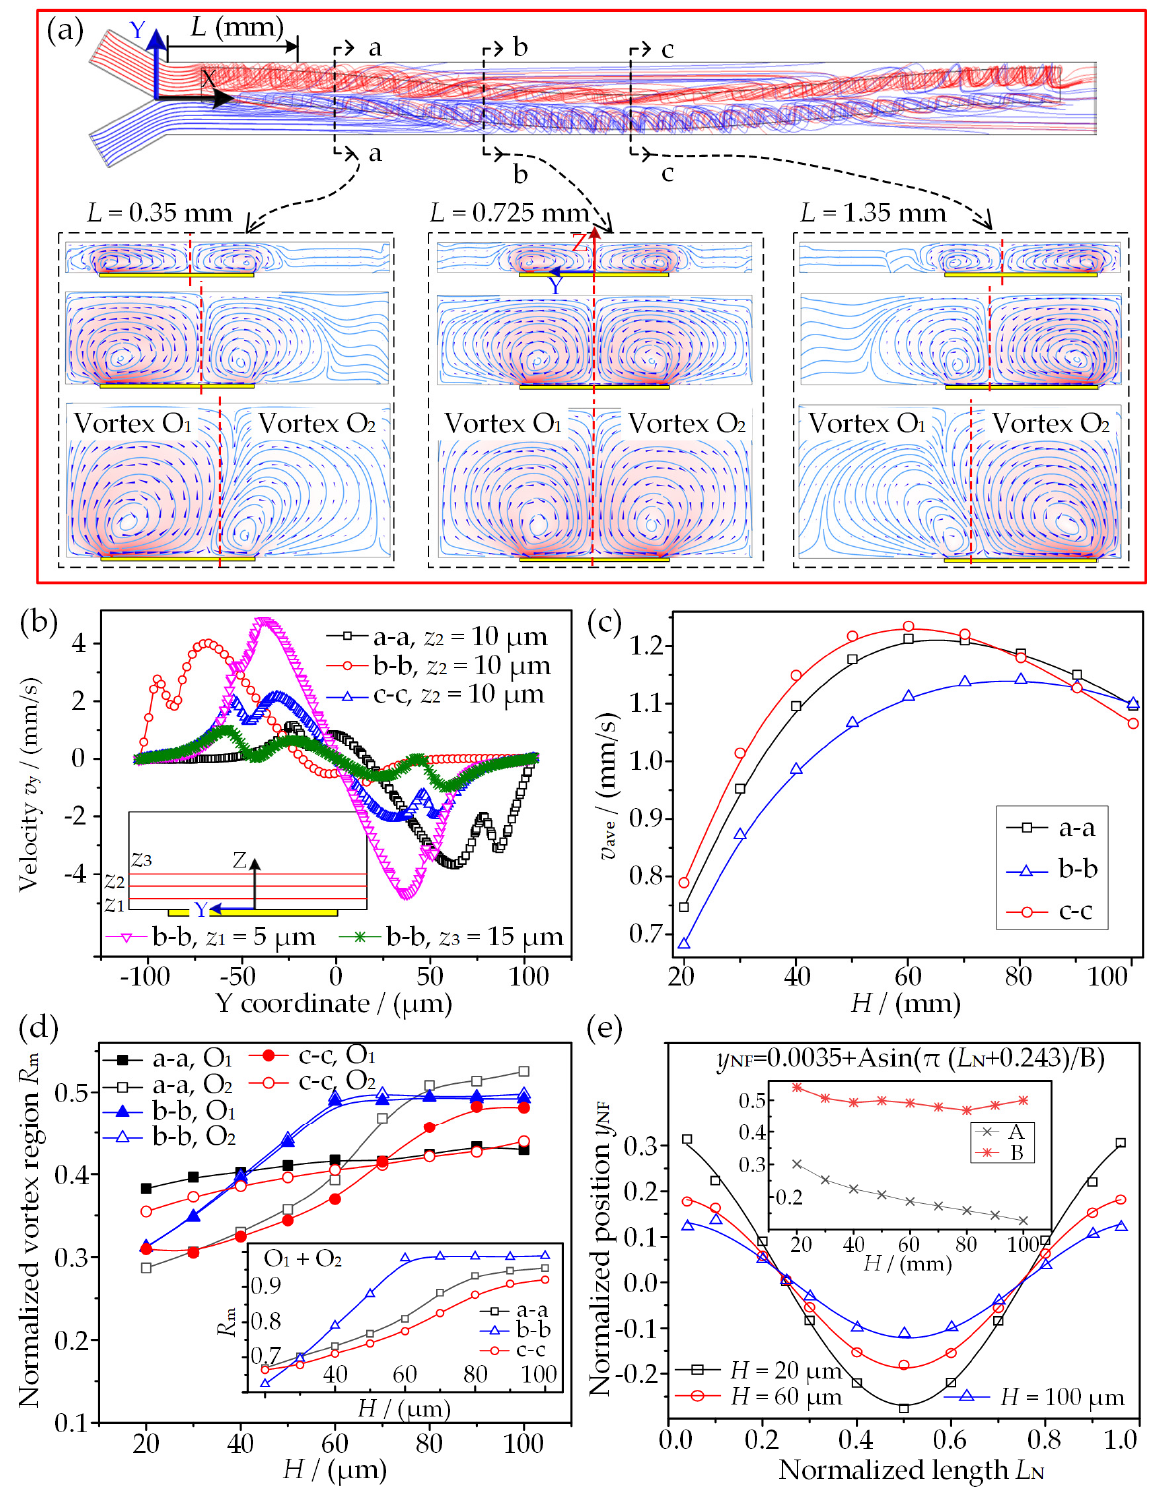
Figure 3. ICEO-microvortex analysis on the SSFE: ( a ) microvortex pattern varying with channel height H at different sections (a-a, b-b, and c-c); ( b ) velocity profiles along with the channel width; ( c ) averaged velocity on the selected cross sections in response to H ; ( d ) the microvortex pair variations with H ; ( e ) variations of the flow stagnant position above SSFE.